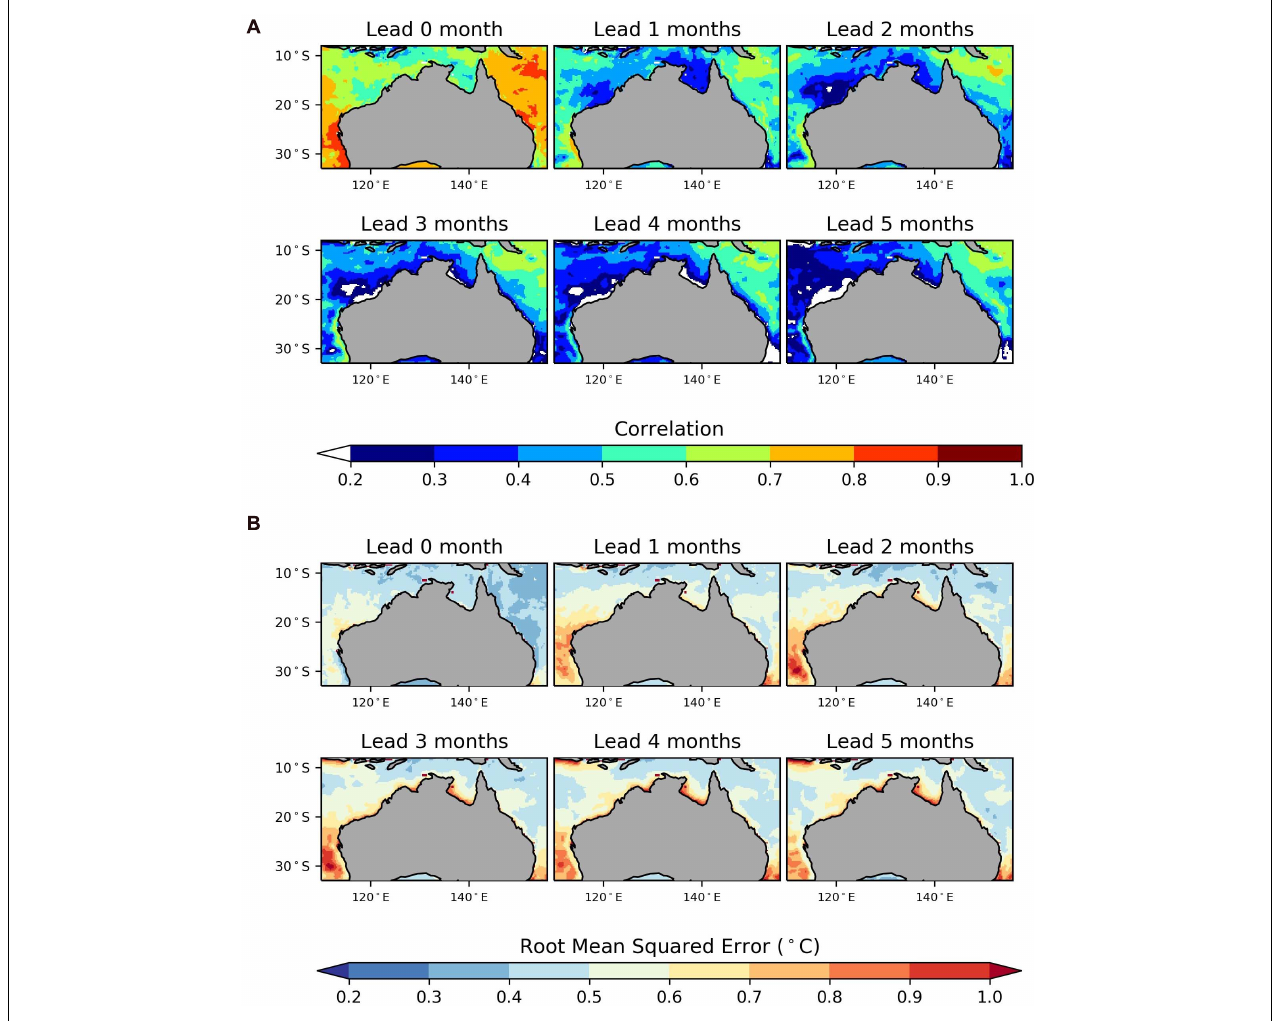
FIGURE 5 | (A) Correlations and (B) root mean square errors (RMSE) for comparisons of forecast and observed monthly SSTA values for November to April 1990–2012 at lead times 0–5 months. Correlations > 0.2 are statistically significant and shaded ( N = 23 years × 6 months, p =